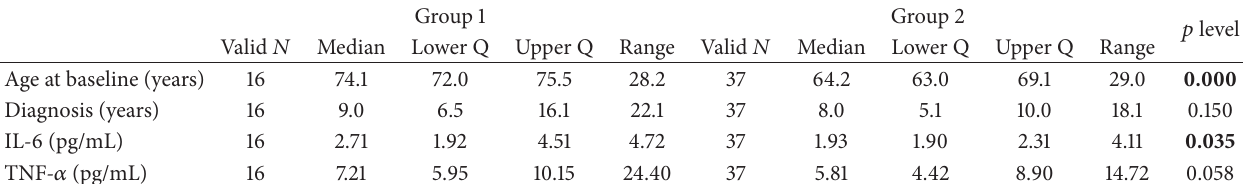
Table 1: Characteristics of the investigated patients and the laboratory results in Groups 1 and